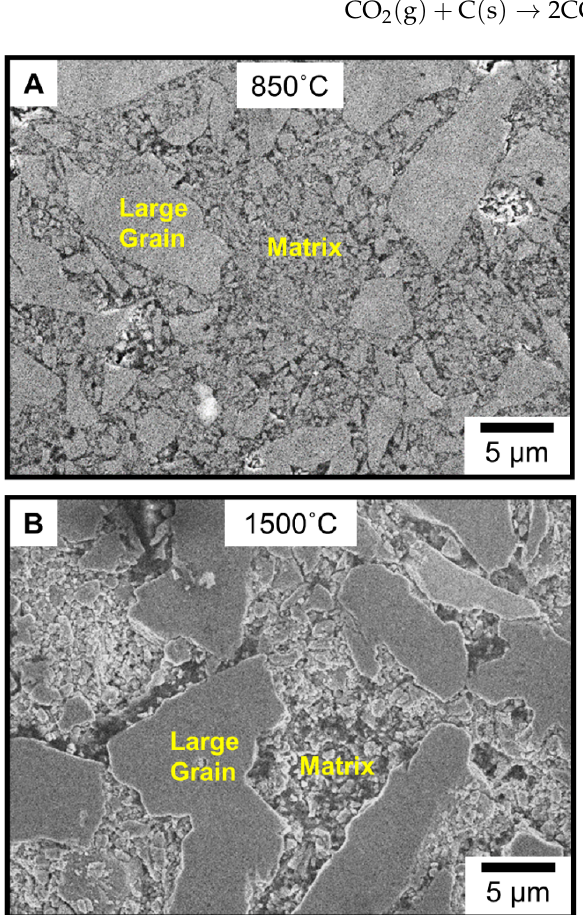
Figure 3. SEM of the polished as synthesized at 850 °C control sample ( A ) and the 1500 °C sample ( B ) revealing rougher unpolished matrix regions and possibly grain pullout during polishing due to inferior mechanical properties.